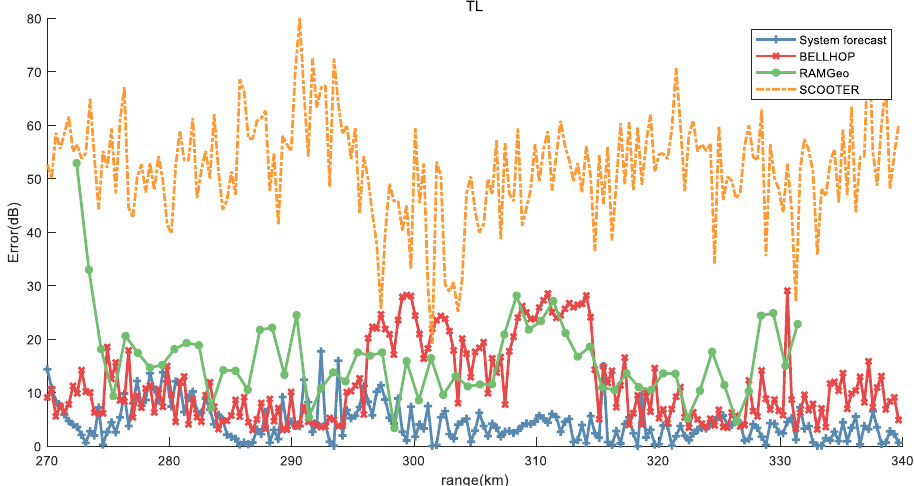
Figure 12. Comparison of absolute error between system prediction and classic model